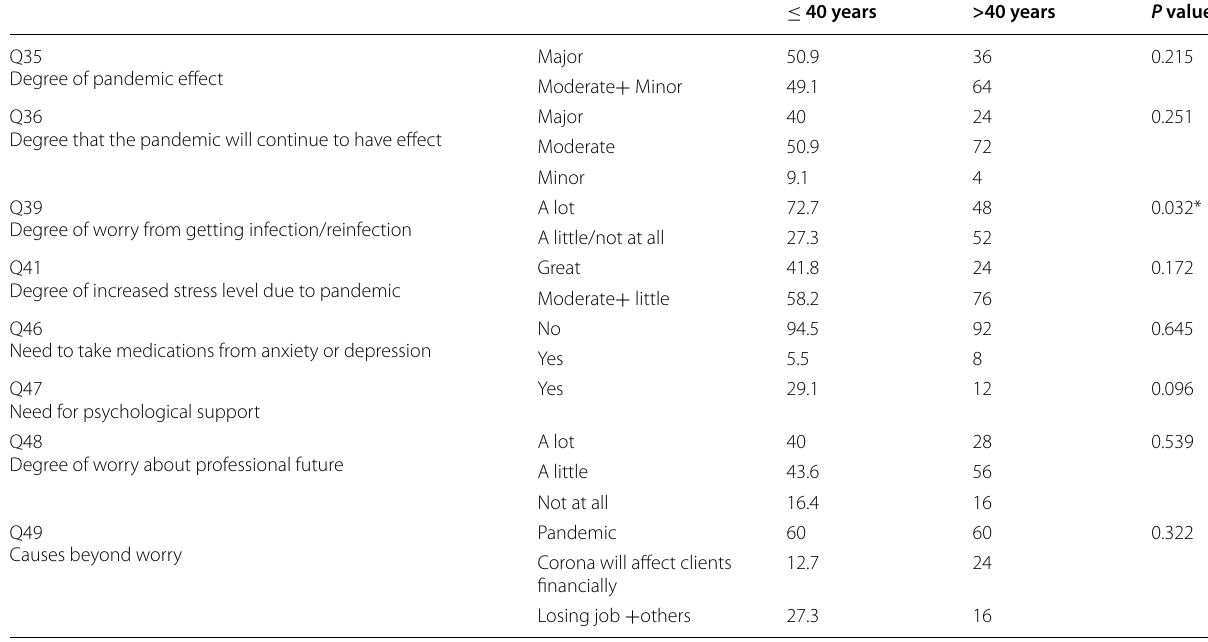
Table 5 Comparison between younger and older age groups regarding the percentage of their responses to some emotional